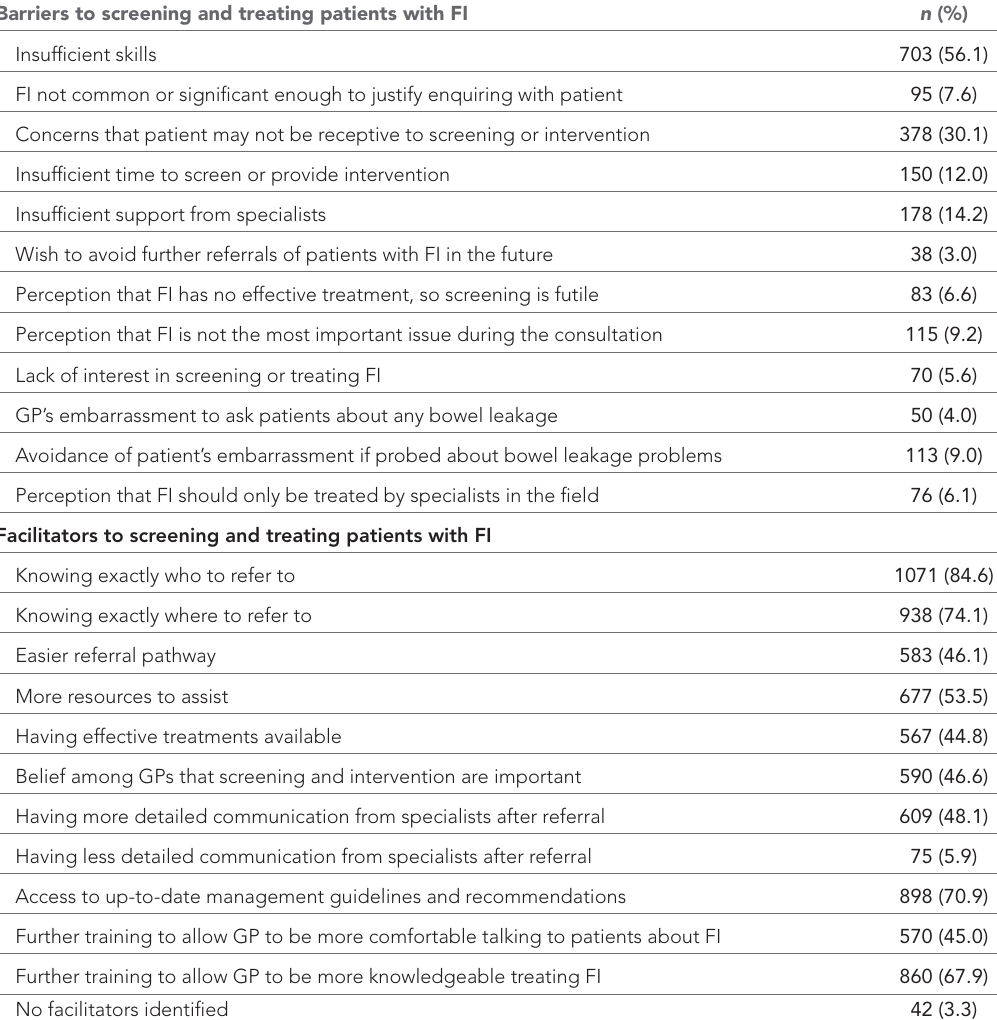
Table 3 Barriers and facilitators in management of FI in primary care Barriers to screening and treating patients with FI Insufficient